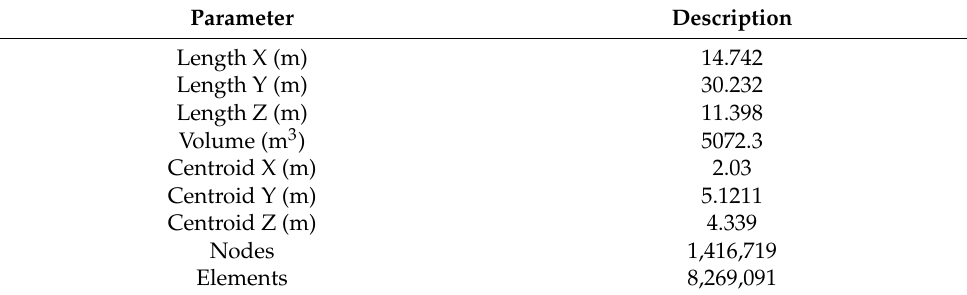
Table 2. Boundary condition for computational fluid dynamics.